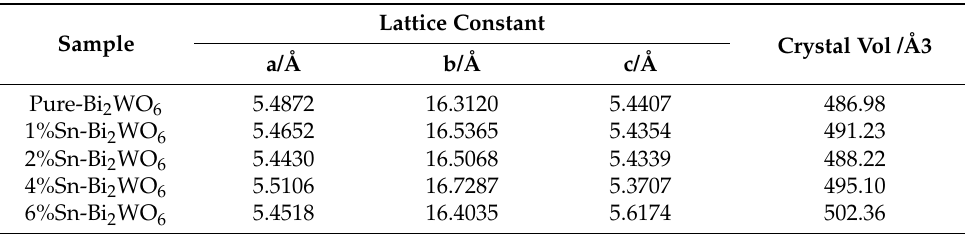
Figure 1. The XRD patterns of samples ( a ) and the peak of (131) crystal plane ( b ). Table 1. The lattice parameters of samples.